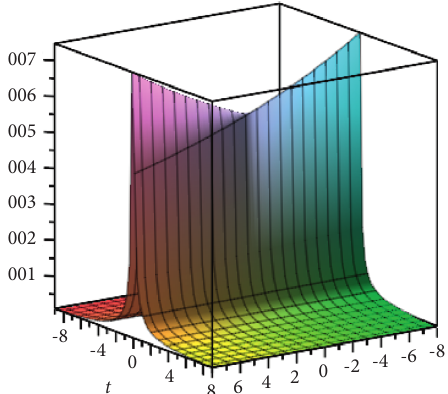
Figure 3: The bright soliton solution of | q � 0 . 2 , f � − 2 . 5, a � − 2 , within theinterval − 8 ≤ c � − 1 , k � 3 , a 1 x ≤ 8 , − 9 ≤ t ≤ 9.